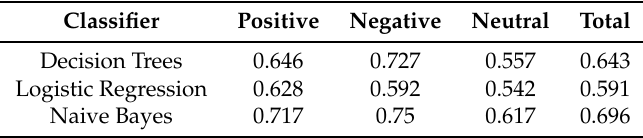
Table 10. F-Measure for Ternary Classification for 12,500 tweets.